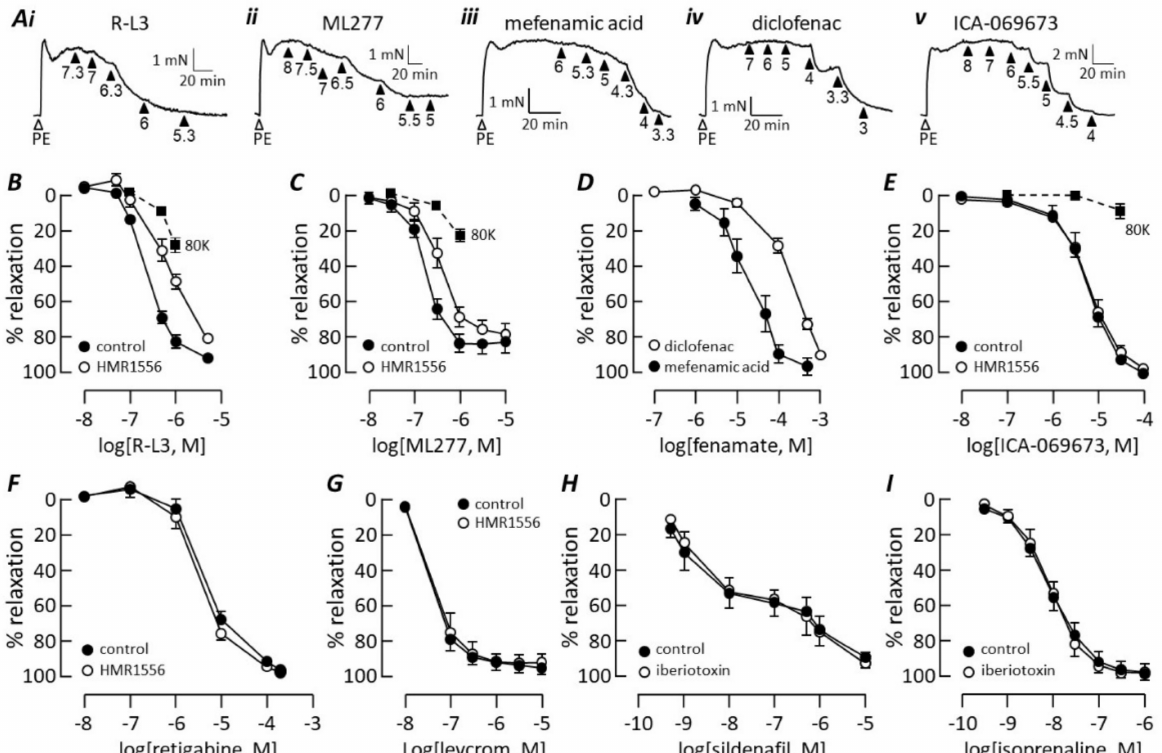
Figure 6. Pharmacology of K channels mediating pulmonary artery relaxation. ( A ) Traces